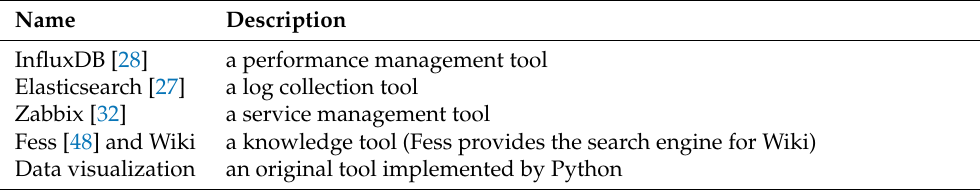
Table 1. List of data collection tools deployed in the experimental